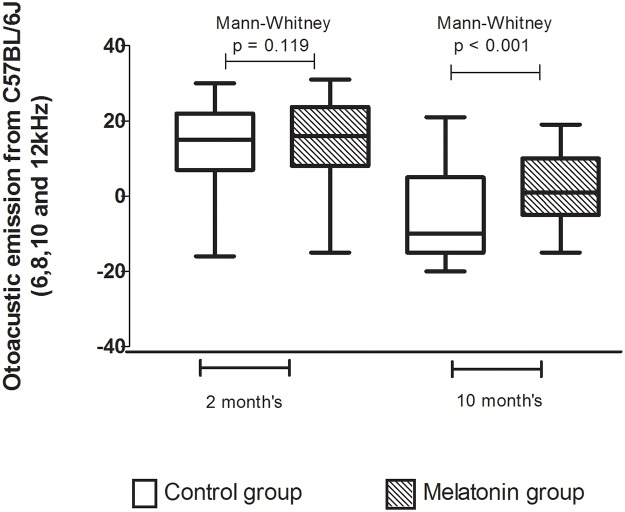
Boxplot of medians, quartiles, maximum and minimum values of the 6, 8 10 and 12 kHz frequency ranges of the control and melatonin-treated groups.